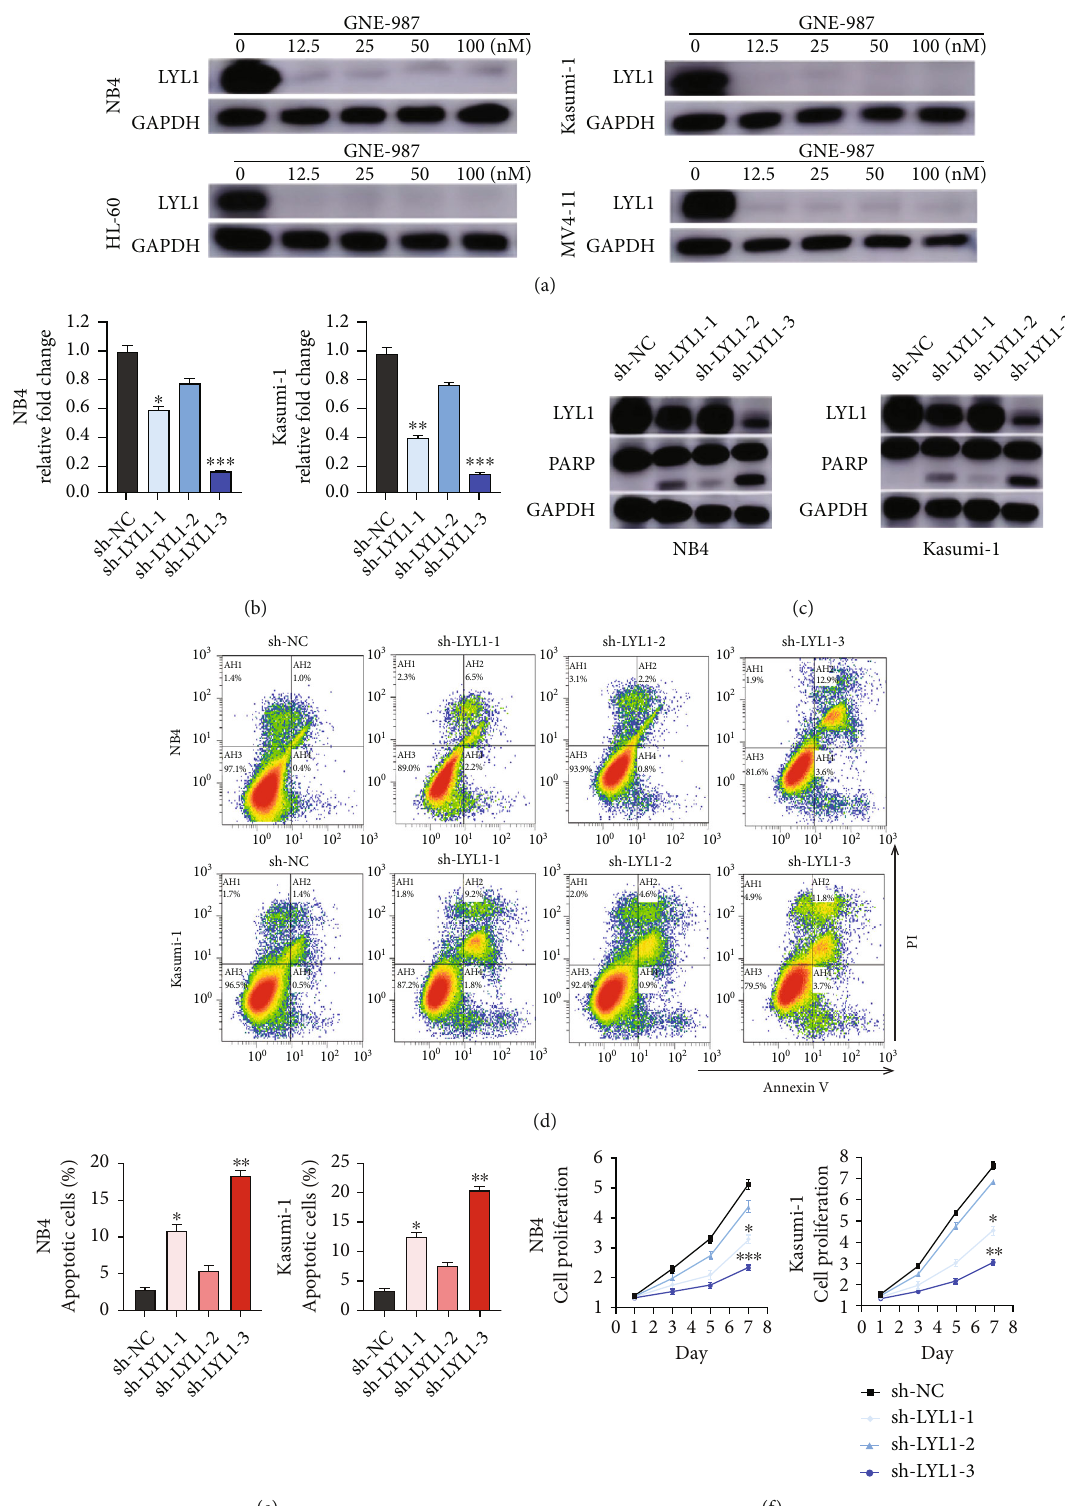
Figure 9: LYL1 is necessary for AML cell growth and survival. (a) Western blot analysis showed that after adding di ff erent concentration gradients of GNE-987 to the AML cell lines, LYL1 downregulation increased. (b) Detection of LYL1 knockdown e ffi ciency in NB4 and Kasumi-1 cell lines by qPCR. (c) Detection of LYL1 knockdown e ffi ciency in NB4 and Kasumi-1 cell lines by Western blotting. (d) Flow cytometry showed that knockdown LYL1 increased the apoptosis rate of NB4 cells and Kasumi-1 cells. (e) Statistical histogram of the apoptosis rate of di ff erent sh-LYL1 sequences. (f) Knockdown of LYL1 can inhibit the proliferation rate of NB4 cells and Kasumi-1